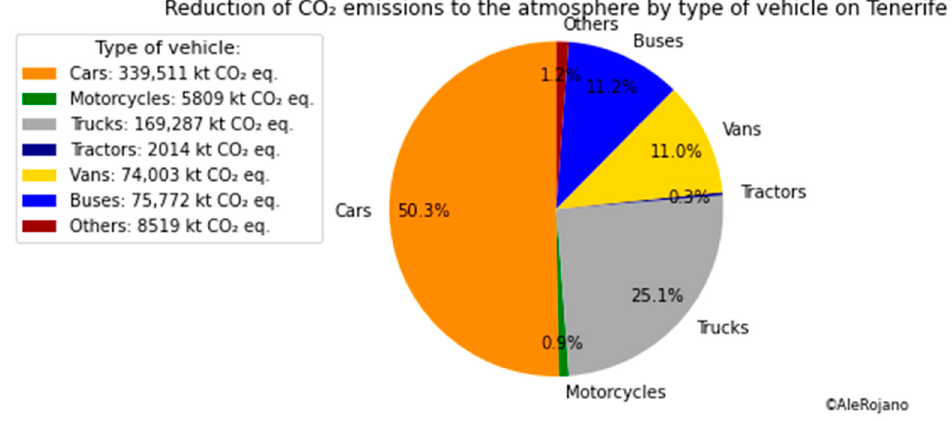
Figure 3. Reduction of CO 2 emissions to the atmosphere by type of vehicle.